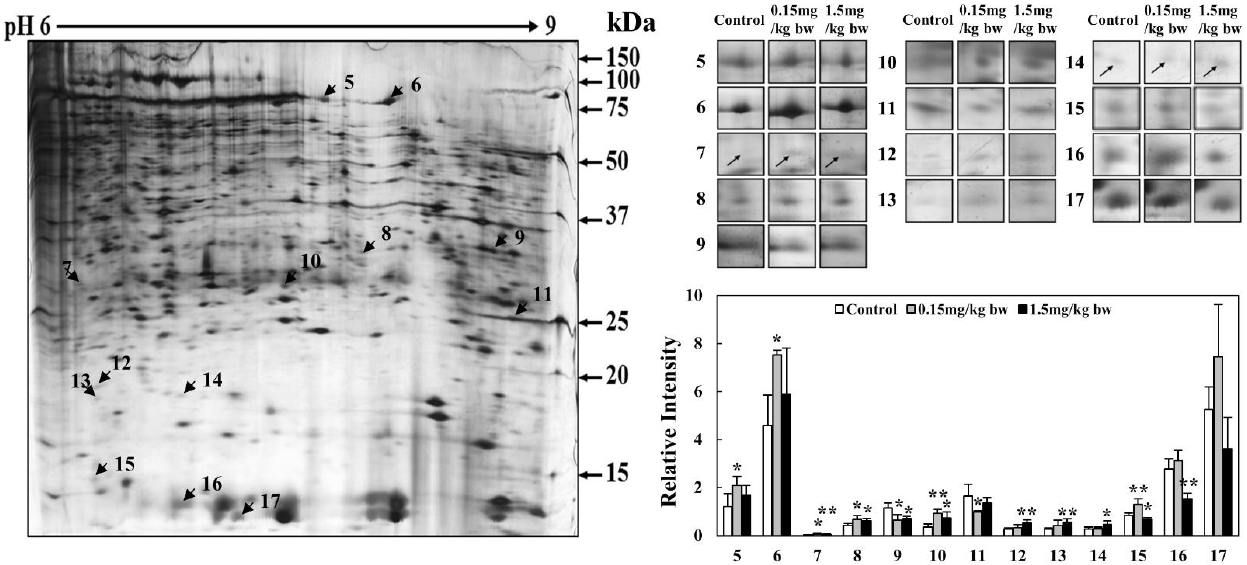
Figure 8. 2-DE analysis of kidney tissue proteins obtained using 6 – 9 pI range strips. Gel pattern of tissue proteins obtained using 6 – 9 pI strips. Protein spots were analyzed using the Progenesis Samespot software program (Nonlinear Dynamics, Newcastle upon Tyne, UK). Spot volumes were normalized by comparison with the total spot volume. The quantity of each spot is presented as the relative intensity. The images represent the mean ± SD of five separate experiments; * and ** indicate p -values of 0.05 and 0.01, respectively, compared with the control.